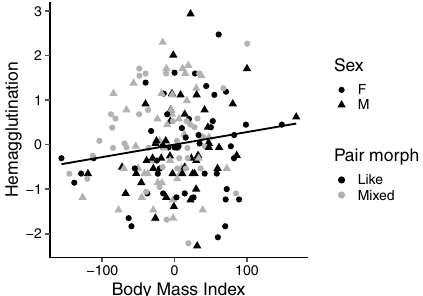
Figure 3. Relationship between hemagglutination titre score and body mass index. Each symbol represents one observation (nestling). Colour represent parental pair morph combination (pair morph): black symbols are offspring produced by like-morphs, grey symbols offspring of mixed-morph parents. Circles are female nestlings, triangles males. Trend line is the linear regression of hemagglutination and the body mass index (y = 0.002x + 0.006, R 2 = 0.019). The hemagglutination titre values were scaled and centred to the mean of the year.